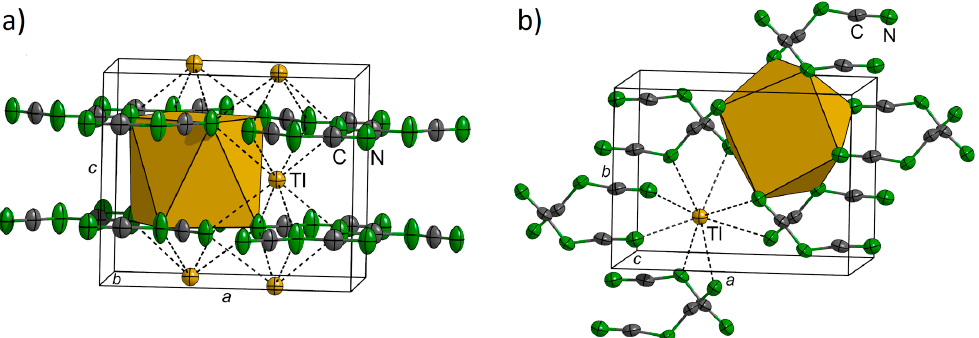
Figure 2. Comparison of the crystal structures of Hg 2 [dca] 2 and calomel, Hg 2 Cl 2 . ( a ) Coordination sphere of Hg in Hg 2 [dca] 2 . The atomic displacement ellipsoids correspond to 90% probability using the refined ADPs. ( b ) Crystal structure of Hg 2 Cl 2 [26] .